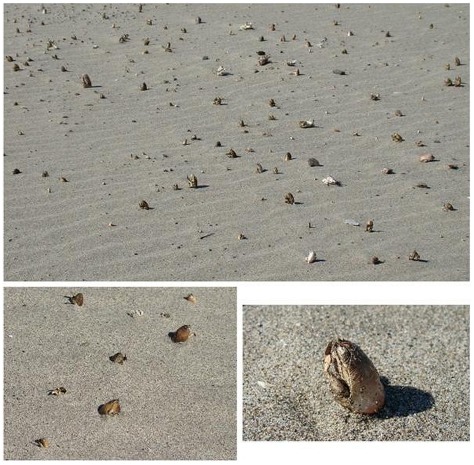
Dead sand crabs, Emerita analoga, stranded in life position at the upper-shore levels of the armoured site at Lebu, illustrate the direct mortality of a dominant lower intertidal invertebrate species observed immediately after the Maule earthquake and tsunami.